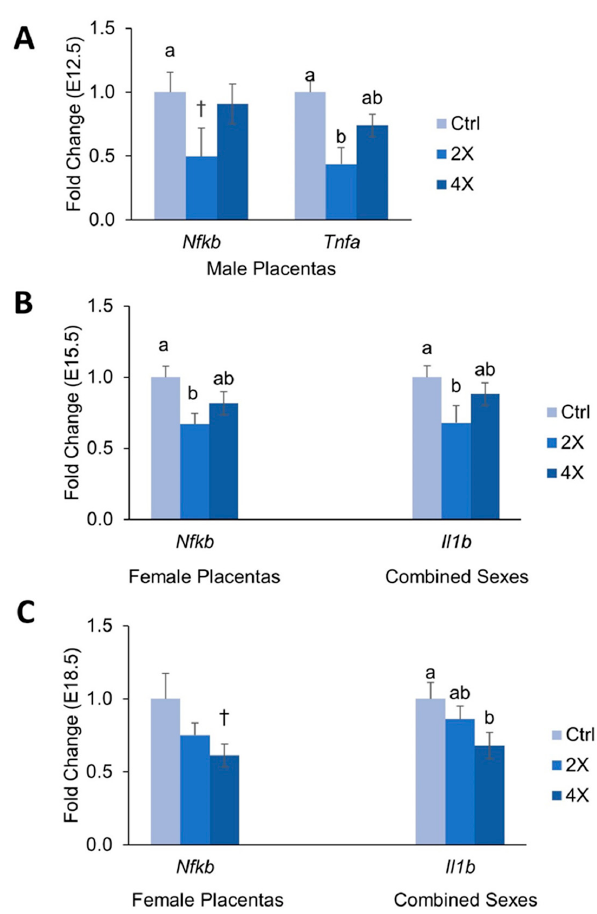
Figure 4. Placental mRNA abundance of inflammatory genes at ( A ) E12.5, ( B ) E15.5, and ( C ) E18.5 by maternal choline treatment. Data are expressed as the fold-change relative to the housekeeping gene Tbp . Data were analyzed using mixed linear models with choline treatment as a fixed effect and maternal ID as a random effect. Litter size and fetal genotype (for E10.5; heterozygous pups were used for E12.5, E15.5, and E18.5) were controlled for in the models as fixed effects. Values are presented as mean ± SEM. Different letters denote significant differences between means of the treatments at p ≤ 0.05. † denotes p < 0.1 versus 1X choline controls. n = 20 placentas per treatment per time point.